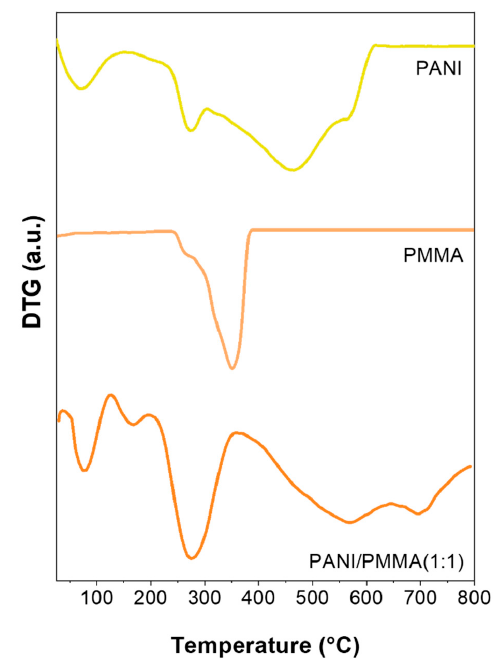
Figure 2. DTG profiles of different electrospun mats: PANI, PMMA and PANI/PMMA (1:1).